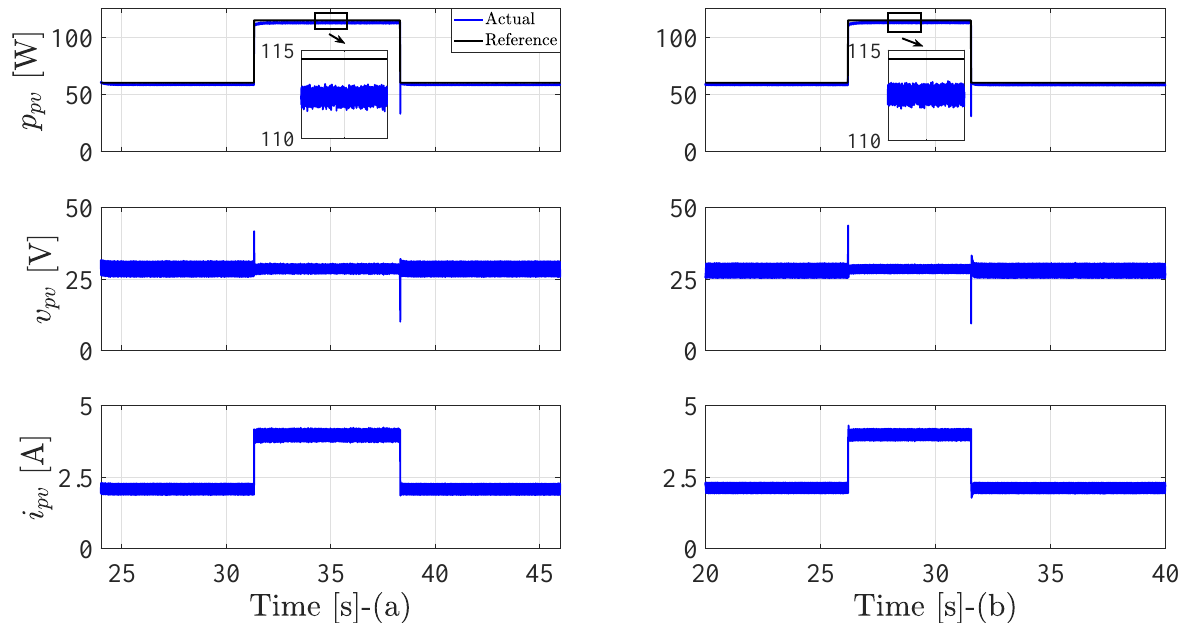
Figure 9. The behavior of the MPPT techniques: ( a ) Conventional P&O method with adaptive step-size; ( b ) proposed predictive method with two adaptive step-size.